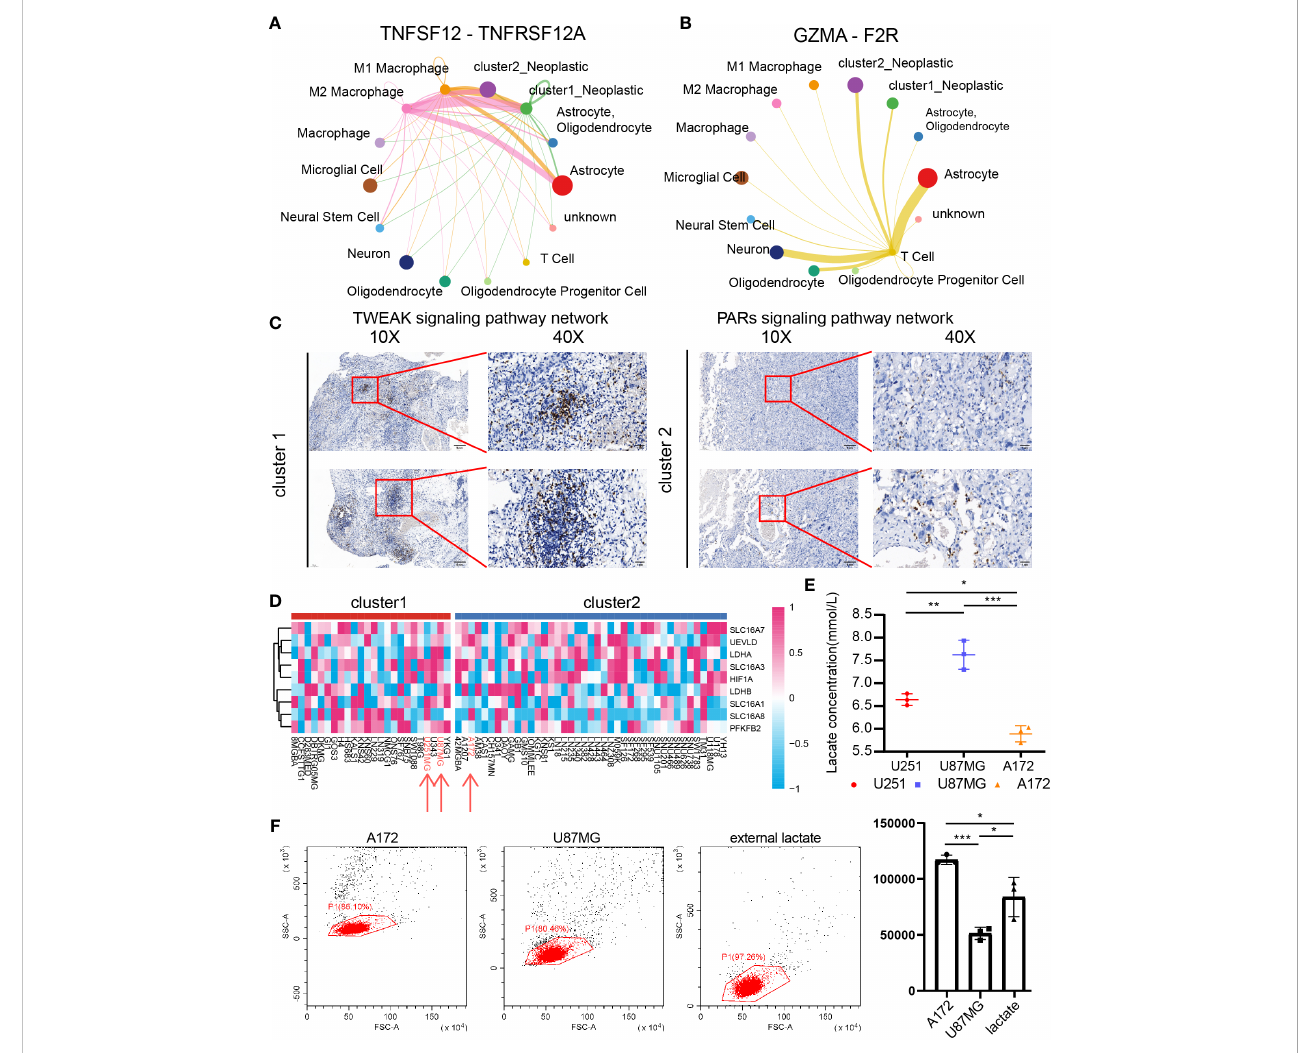
FIGURE 8 The role of CD8+ T cells in cluster 1 and cluster 2 samples. Cluster 1 and cluster 2 tumor cell communication with macrophage and CD8+ T cells through TNFSF12-TNFRSF12A (A) and GZMA-F2R (B) , respectively. (C) IHC revealed the CD8+ T-cell in fi ltration difference between cluster 1 and cluster 2 samples. (D) The cluster model in central nervous system tumor cell lines. (E) Lactate concentrations in U251MG, U87MG, and A172. N = 3. *P < 0.05, **P < 0.01, ***P < 0.001. (F) Percentage of migrated of CD8+ T cells after coculture with U87MG and A172 for 48 h. N = 3. *P < 0.05, **P < 0.01, ***P <